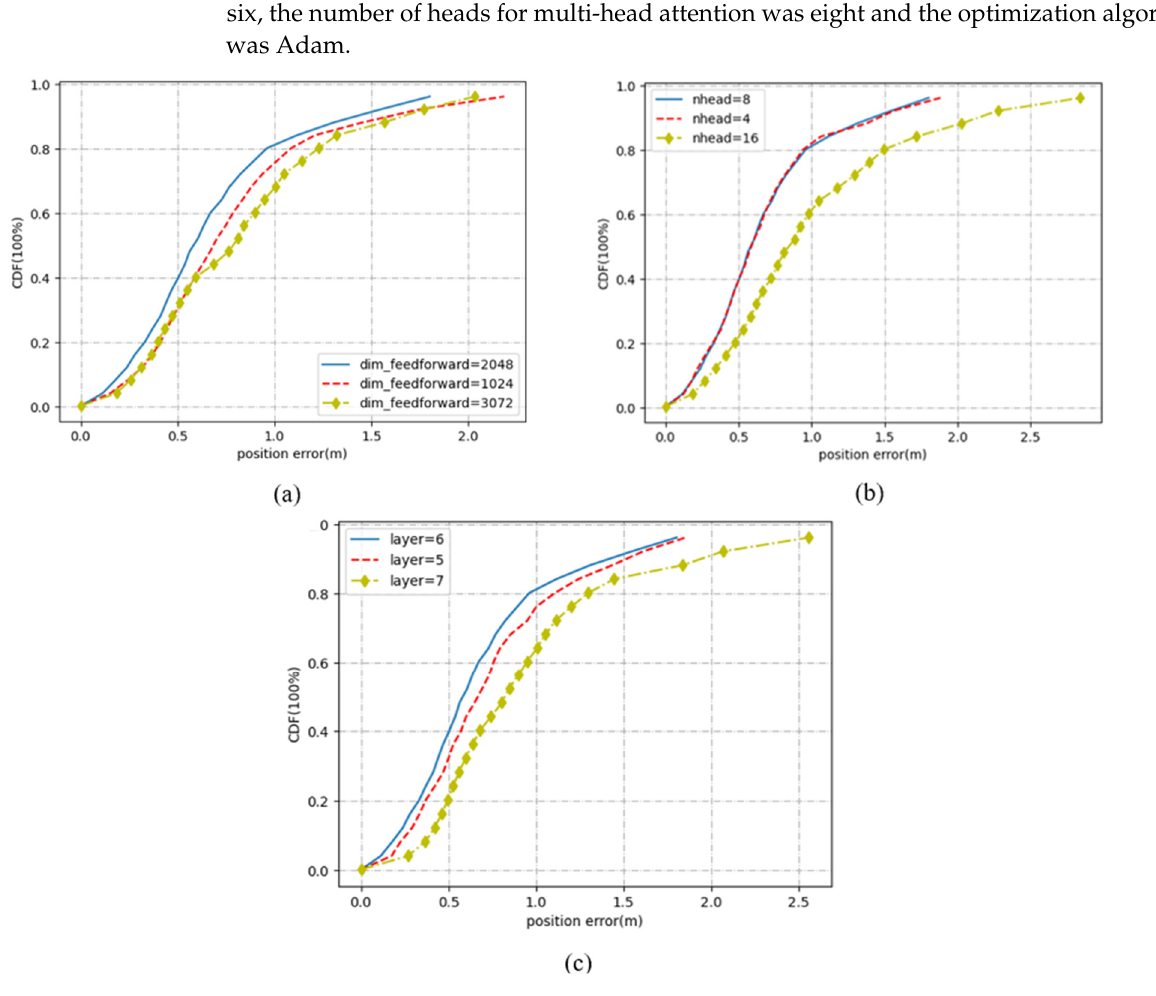
Figure 7. The statistical positioning errors with different hyper-parameters. These include ( a ) posi- tion error with different dimensions of the feedforward layer; ( b ) position error with different number of heads; ( c ) position error with different layers.